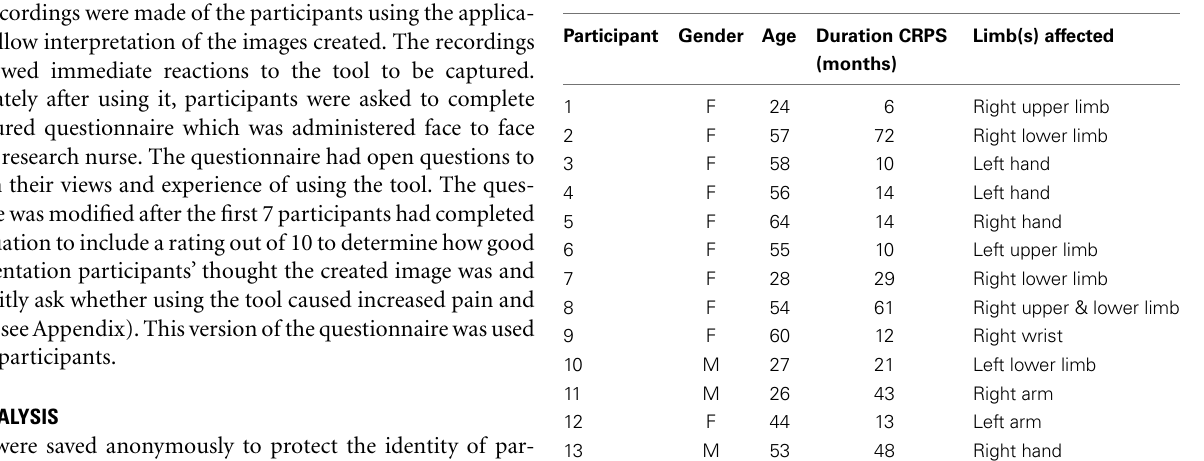
FIGURE 2 | Starting screen with options for manipulating the body perception avatar . Menus for moving body segments (height, depth, left/right, and rotate), scaling (overall size, thickness, length), for hiding